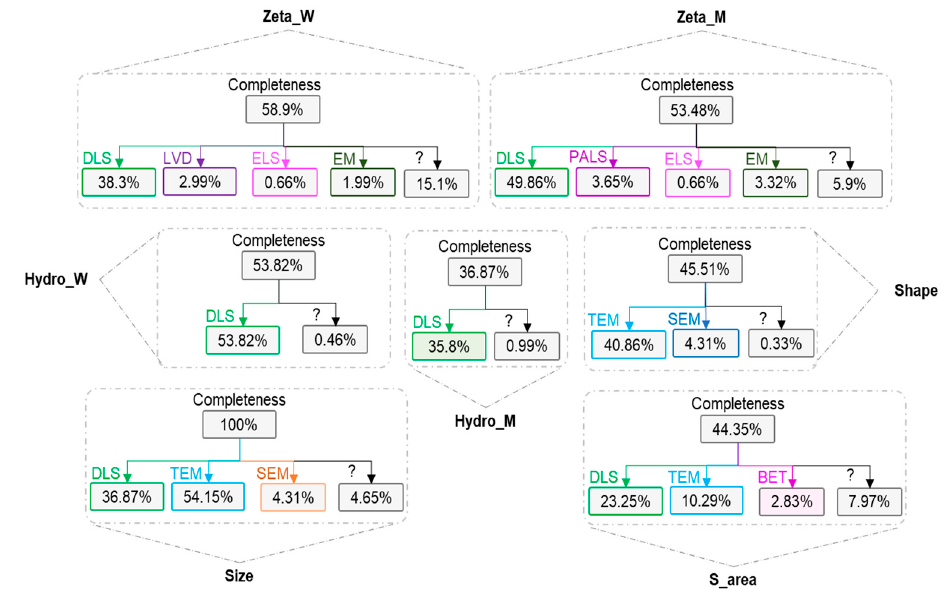
Figure 5. Physicochemical characterization completeness and experimental methodology.